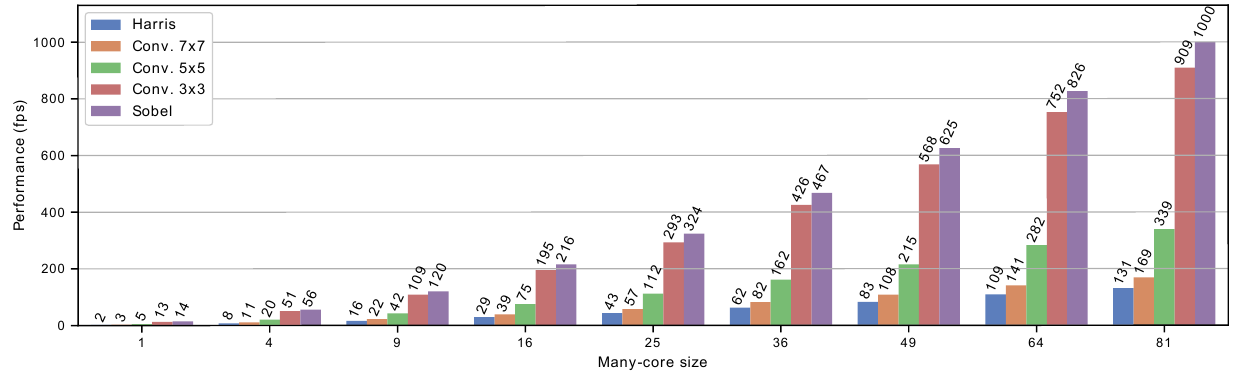
Figure 12. Performance in frames per second per architecture, all running in a testbench without a camera.